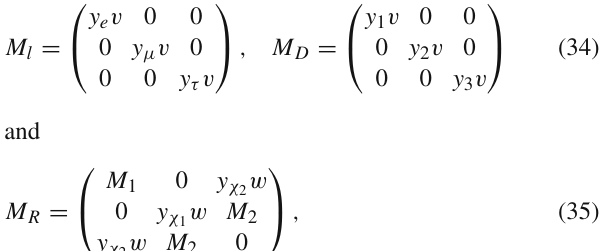
Fig. 8 Correlation between (θ − δ) for D 23 2 texture with NH under LMA (left) and LMA-D (right)